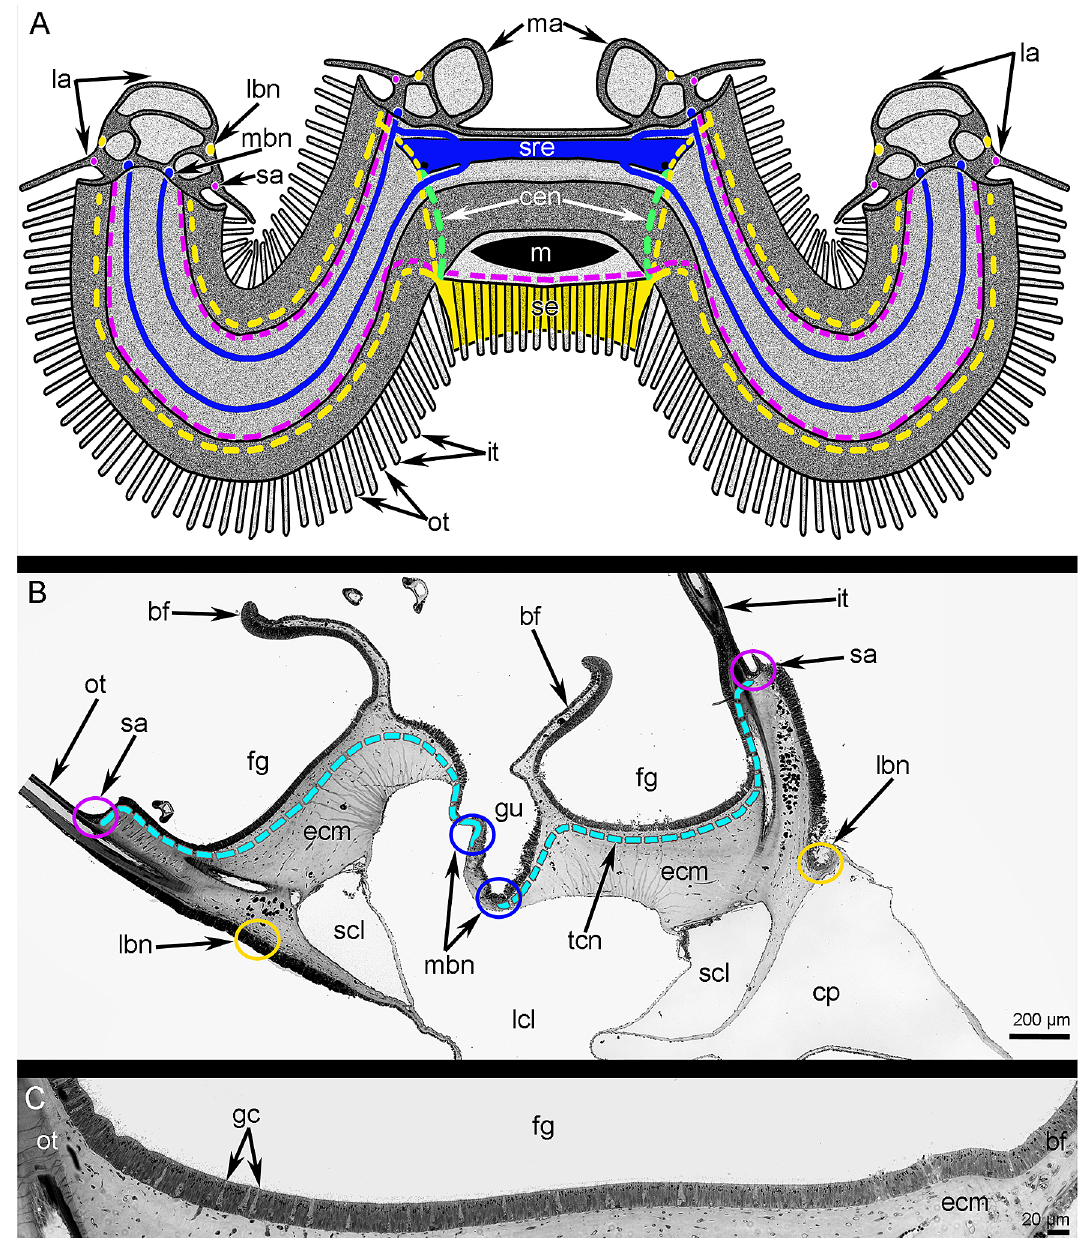
Figure 3. Location of ganglia and brachial nerves in the lophophore of Coptothyris grayi . ( A ) The scheme of central part of the lophophore; lateral and median arms are cut. Dotted lines are used to show nerve elements, which are screened by lophophore structures (tentacles and brachial fold). ( B ) Semi-thin cross section of the lateral arm. The location of different nerves is marked by circles of different colors, which correspond to the colors of nerves in Figs. 3A and 6. ( C ) Semithin section of the food grove: the brachial fold is to the right; the tentacles are to the left. Abbreviations: bf—brachial fold; cen—circumenteric nerve; cp—coelomic pouch; ecm— extracellular matrix; fg—food groove; gc—gland cells; gu—gutter; it—inner tentacle; lbn—lower brachial nerve; lcl—large canal of the lophophoral coelom; m—mouth; ma—medial arm; mbn—main brachial nerve; ot—outer tentacle; sa—second accessory brachial nerve; scl—small canal of the lophophoral coelom; se—subenteric ganglion; sre—supraenteric ganglion; tcn—trace of the cross each other (Figs. 2B, 3B, and 7A). According to CLSM, each main brachial nerve is formed by longitudinal neu- rite bundles, which exhibit acetylated alpha-tubulin-like immunoreactivity (Fig. 7B). Each main brachial nerve is completely located in the epithelium of the arm and resembles a compact neurite bundle that is 20–25 µm in diameter (Fig. 8A). Neurite bundles form a large nerve tract, which is divided into several portions by basal projections of supportive cells (= radial glia cells) (Fig. 8A). Transmission electron microscopy (TEM) revealed that these projections contain electron-dense intermediate filaments, which extend from the apical to the basal